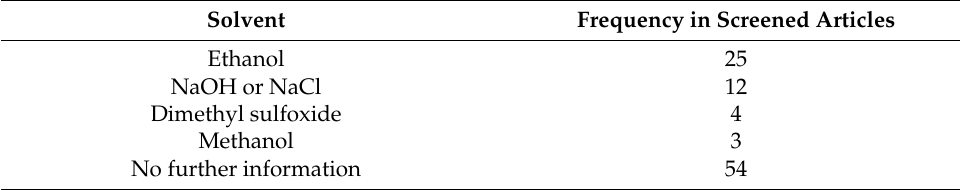
Table 3. Frequency of used solvents in screened literature ( n =